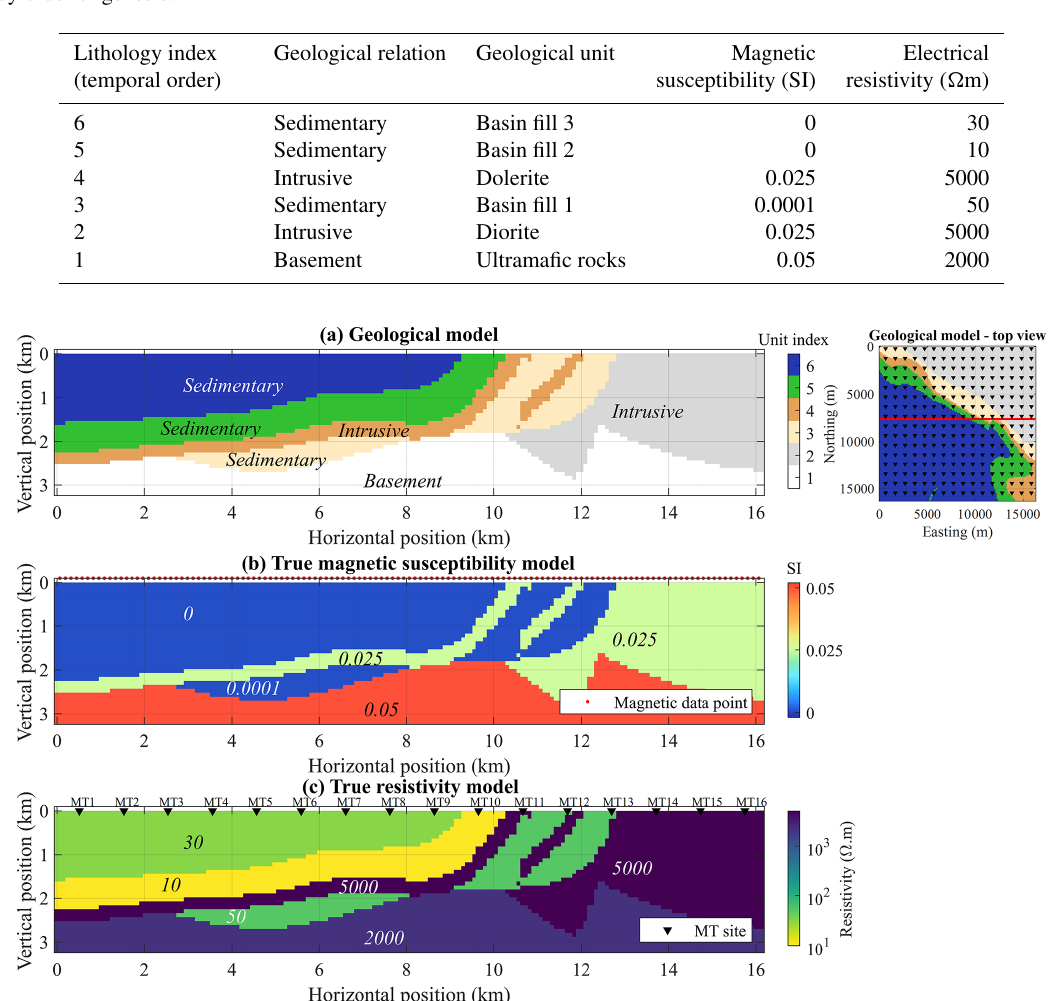
Figure 2. (a) True geological model, (b) true magnetic susceptibility model and (c) true resistivity model with the simulated MT acquisition setup geometry in the top-left corner where triangles represent MT sites. The red dots in (b) represent the 2D magnetic data line; MT sites are marked in (c) . The inset in the top-right corner shows a top view of the model with the magnetic data line in red and MT sites as